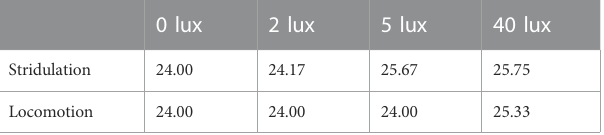
TABLE 1 The median values of stridulation and locomotion daily activity cycle periods in the experimental groups under LD (0 lux, n = 20), LA of 2 lux ( n = 6), 5 lux ( n = 7), and 40 lux (LL, n = 6, n = 7 for stridulation and locomotion behavior,